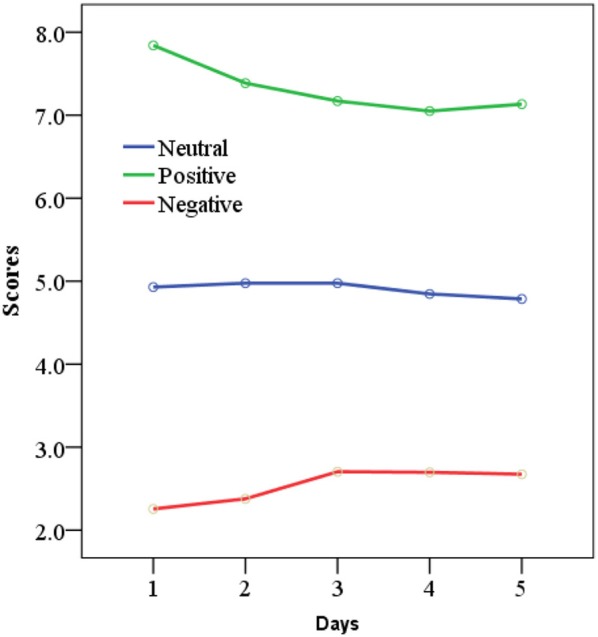
Valance ratings of neutral, positive, and negative states in 5-day experiment.